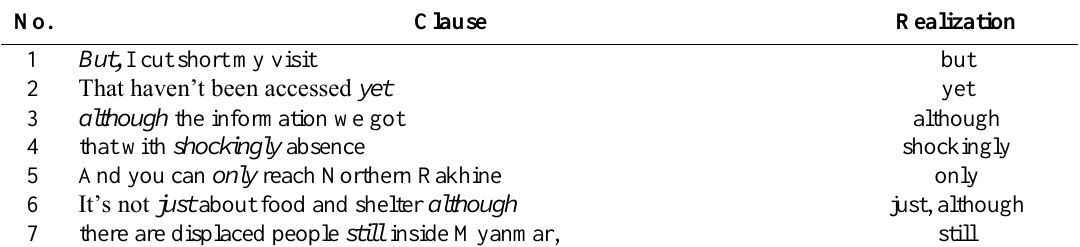
Table 2. Heteroglossic - Contract – Disclaim – Counter (HCDC)